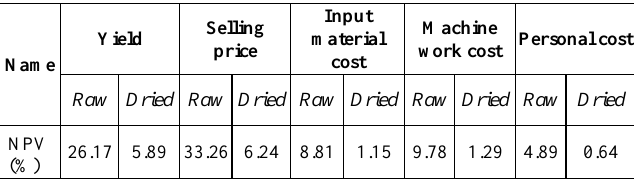
Table 12. Elasticity values of main factors affecting income and